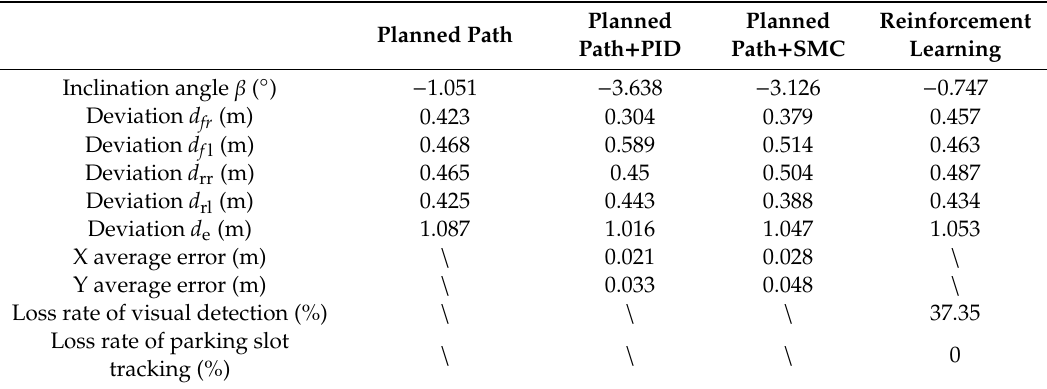
Table 1. Experimental data of 60 ◦ perpendicular parking.